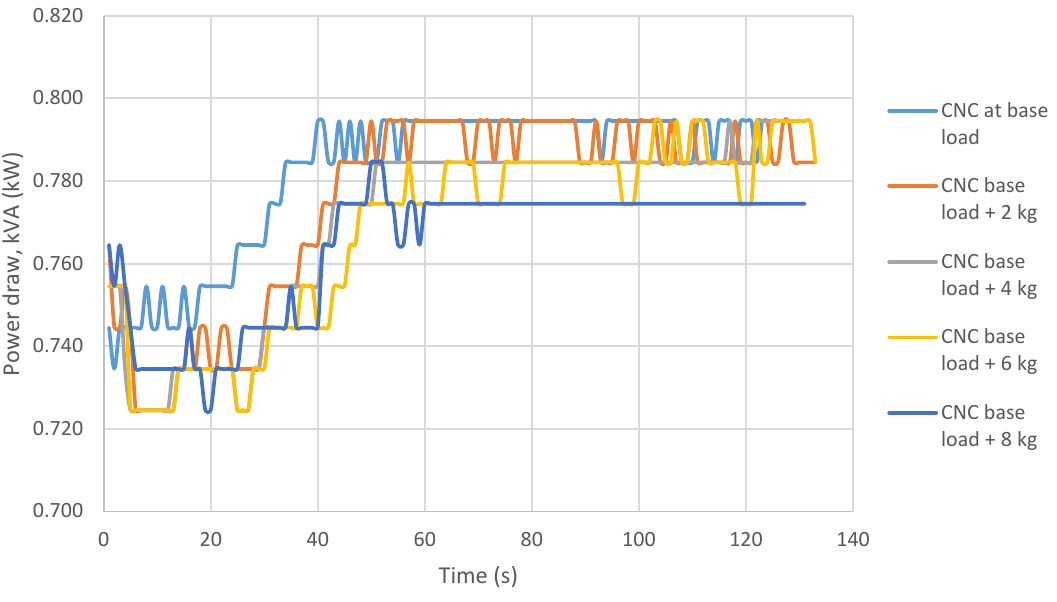
Figure 5. Power draw vs. speed for all CNC payloads.